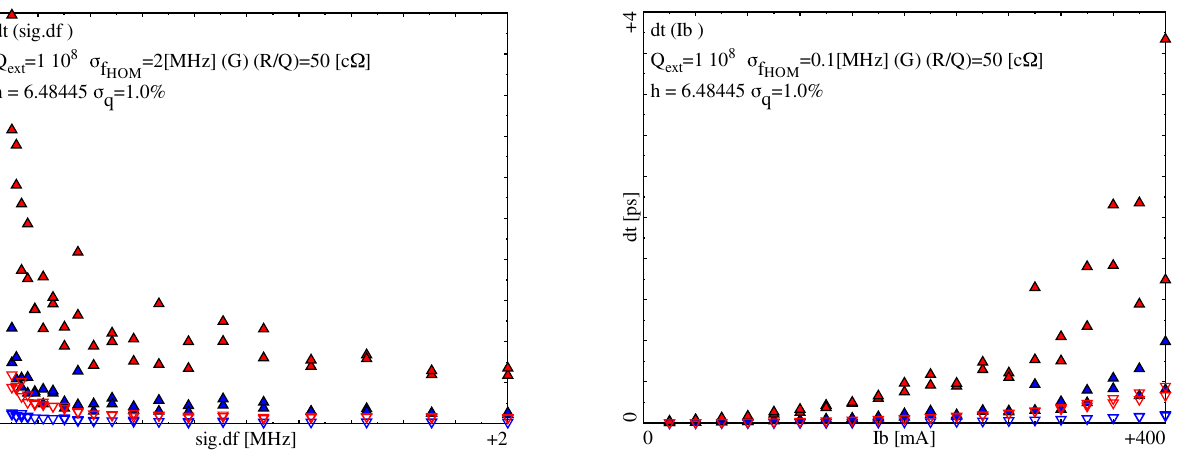
FIG. 26. (Color) dt as a function of (cid:1) (cid:3) f for two consecutive pulses with Q ext ¼ 10 8 , I b ¼ 400 mA ; red: worst bunch in pulse; blue: rms; filled upward triangles: with 1% charge scatter; hollow downward triangles: without bunch noise.